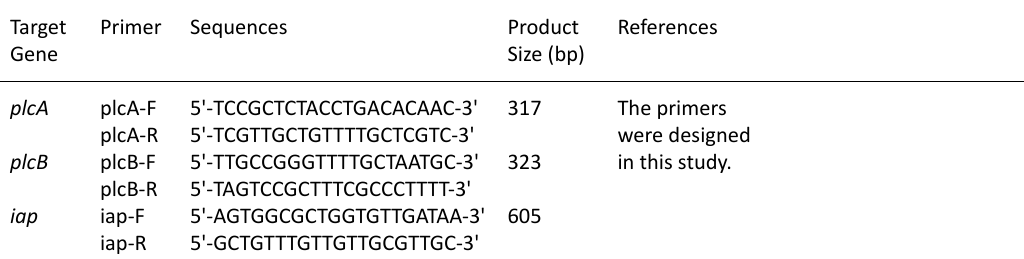
Table 3. Primers used for detection of virulence-associated genes in L. monocytogenes isolates Target Primer Sequences